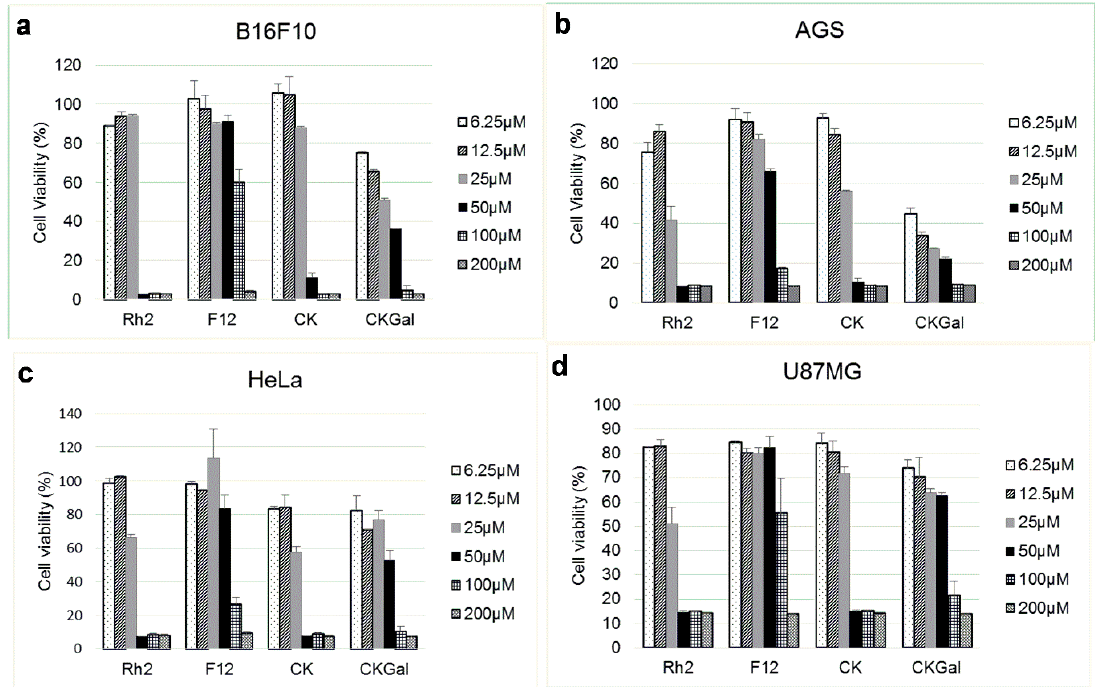
Figure 4. The growth inhibitory effect of ginsenosides Rh2, F12, CK, and CKGal on cancer cells. ( a ) B16F10 (skin cancer), ( b ) AGS (gastric cancer), ( c ) HeLa (cervical cancer), and ( d ) U87MG (brain cancer). The cells were treated with increasing concentrations of compounds (6.25, 12.5, 25, 50, 100 and 200 µmol) for 72 h and cell growth was measured by MTT assay.